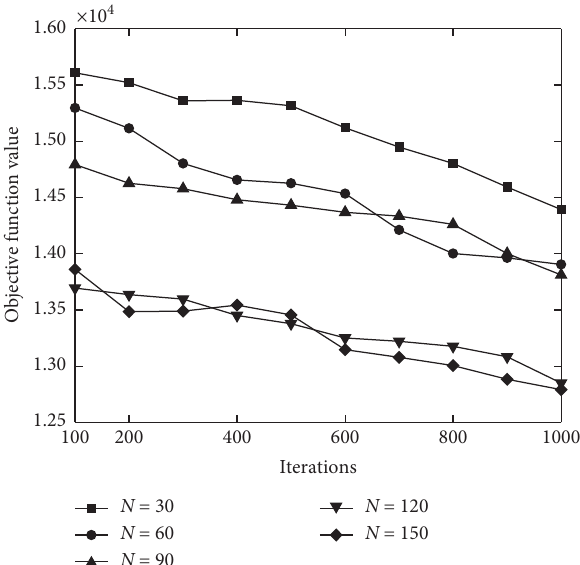
Figure 7: Objective function values under different population sizes.